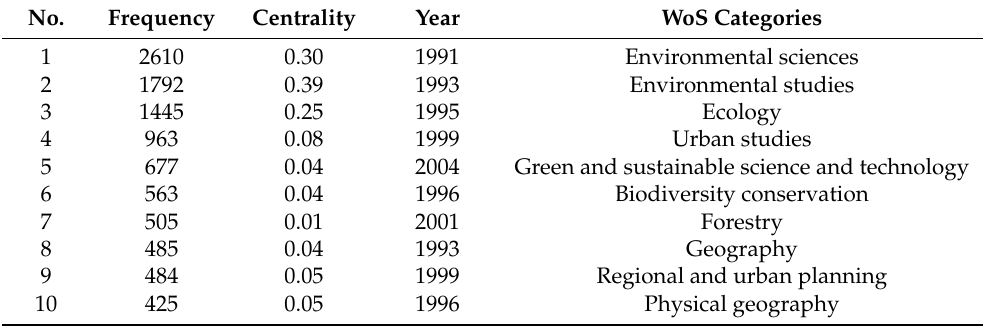
Figure 7. Co-occurrence network of research subjects. Table 5. List of the most influential categories.